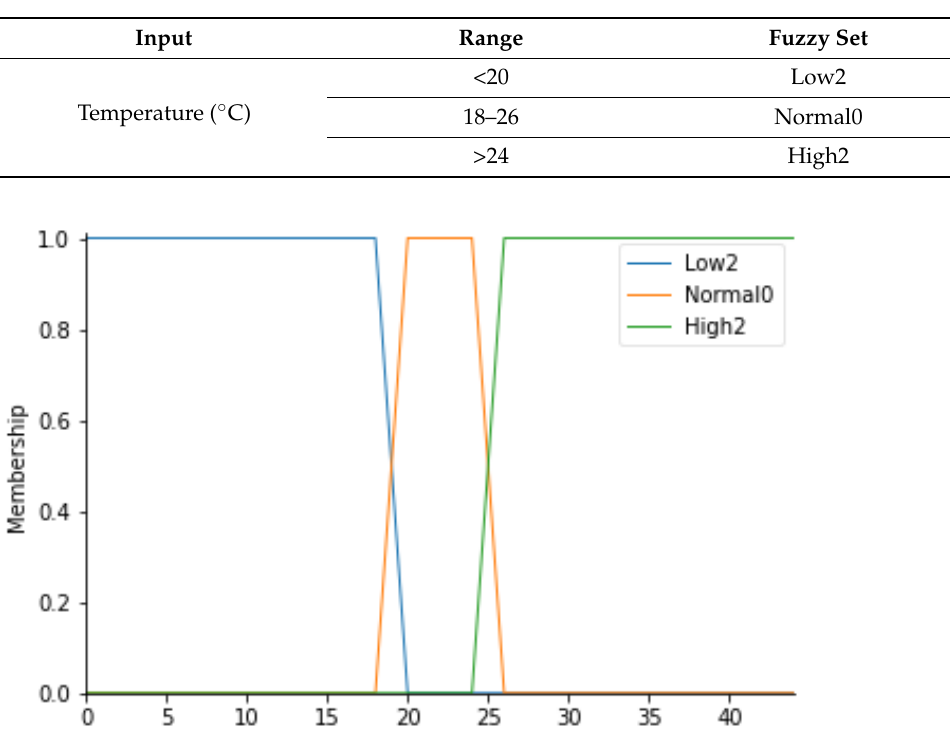
Figure 4. T membership functions.